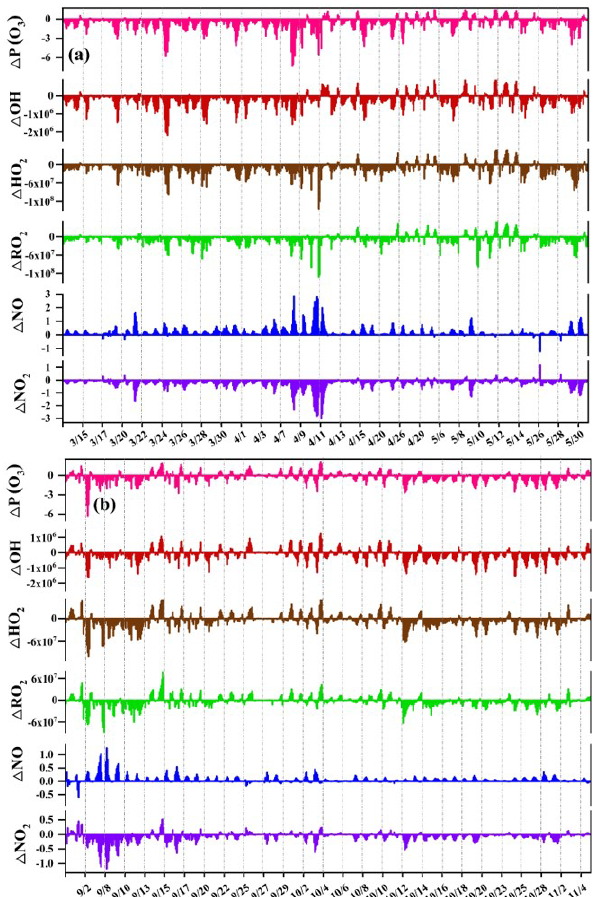
Figure 7. The differences of O 3 net production (cid:49)P (O 3 ), (cid:49) OH, (cid:49) HO 2 , (cid:49) RO 2 , (cid:49) NO, and (cid:49) NO 2 between the SC1 and the SC2 during the daytime (06:00–17:00) in (a) spring and (b) au- tumn (Unit: ppbvh − 1 for (cid:49)P (O 3 );ppbv for (cid:49) NO and (cid:49) NO 2 ; moleculescm − 3 for (cid:49) OH, (cid:49) HO 2 , and (cid:49) RO 2 ). The SC1 scenario was the base scenario putting all detected data (i.e. VOCs, trace gases, and meteorological parameters) into the model with all reac- tion pathways of the MCM mechanism, and the SC2 disabled the PAN chemistry, which is the only difference between SC1 and